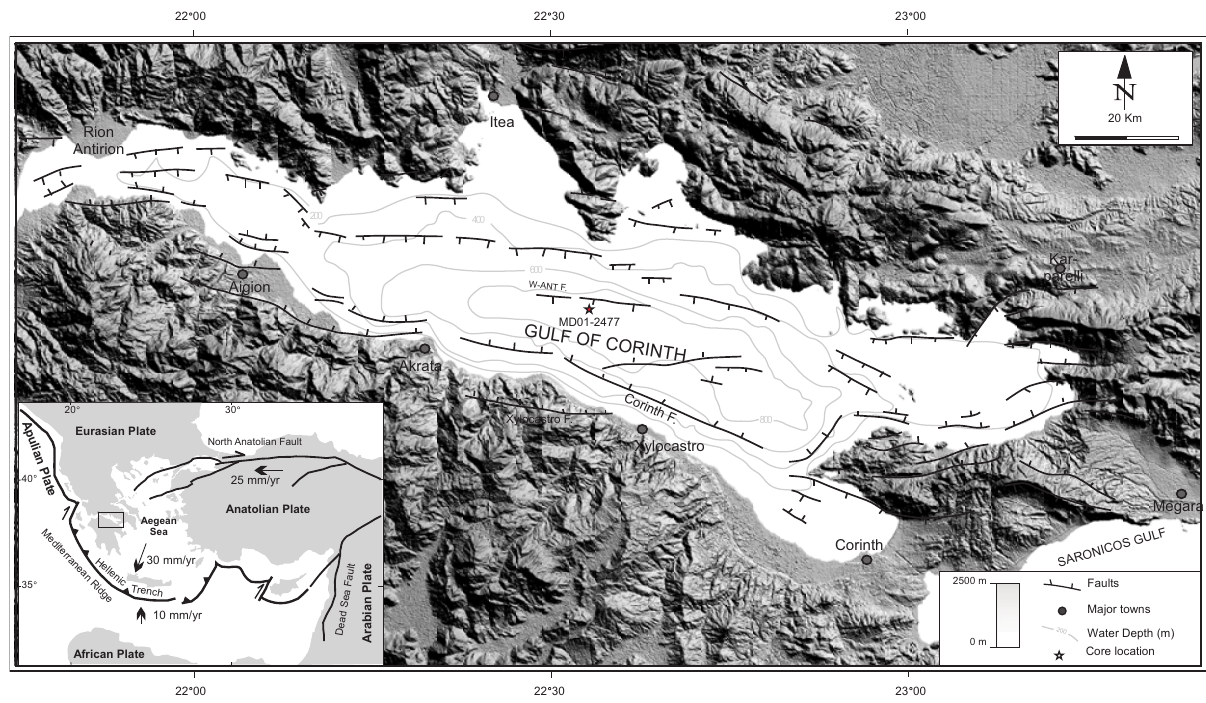
Figure 1. Simplified geodynamic setting of the Gulf of Corinth with the location of the MD01-2477 core. The locations of major faults and the bathymetry are from Moretti et al. [2003] (200 m isobaths intervals); onshore relief is an extract from NASA/SRTM. Motion vectors of the North Anatolian fault after Le Pichon et al. [1995], and of the Aegean and African plates relative to Eurasia after McClusky et al.